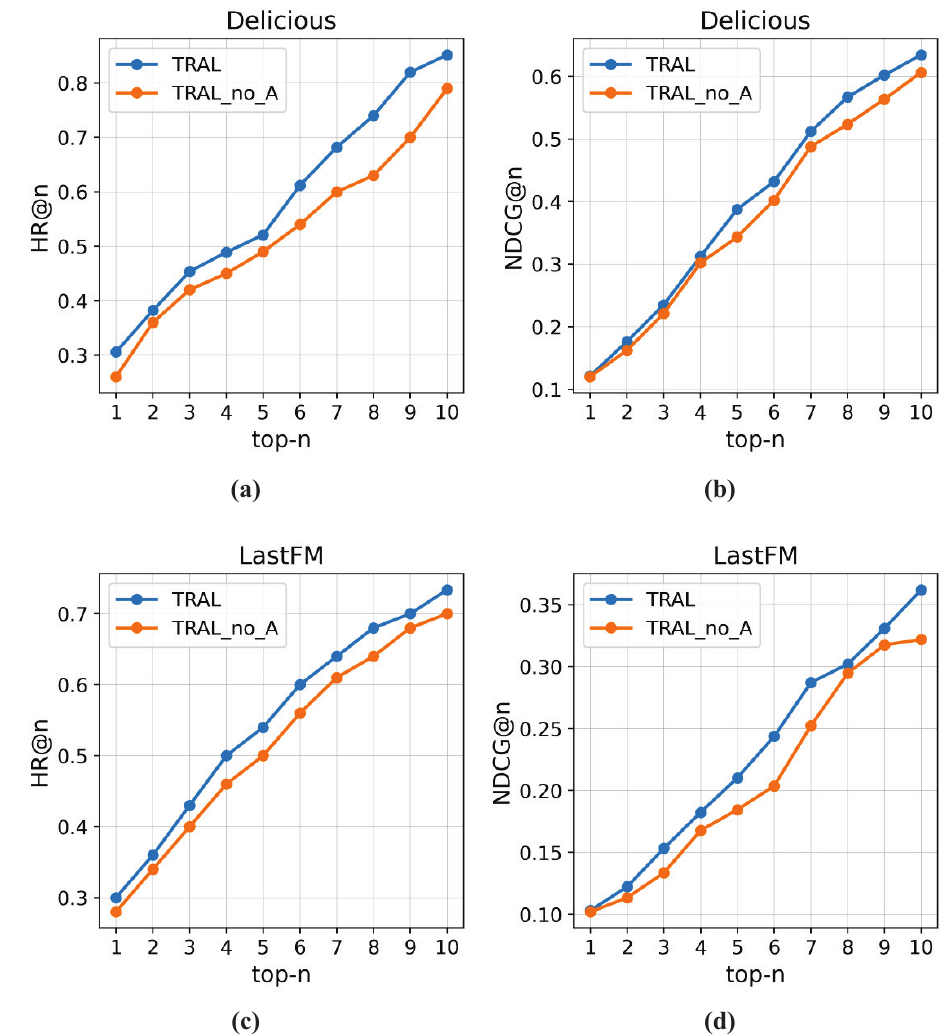
Figure 3. Performance comparison in terms of HR@n and NDCG@n on the two datasets. ( a ) HR@n on Delicious. ( b ) NDCG@n on Delicious. ( c ) HR@n on LastFM. ( d ) NDCG@n on